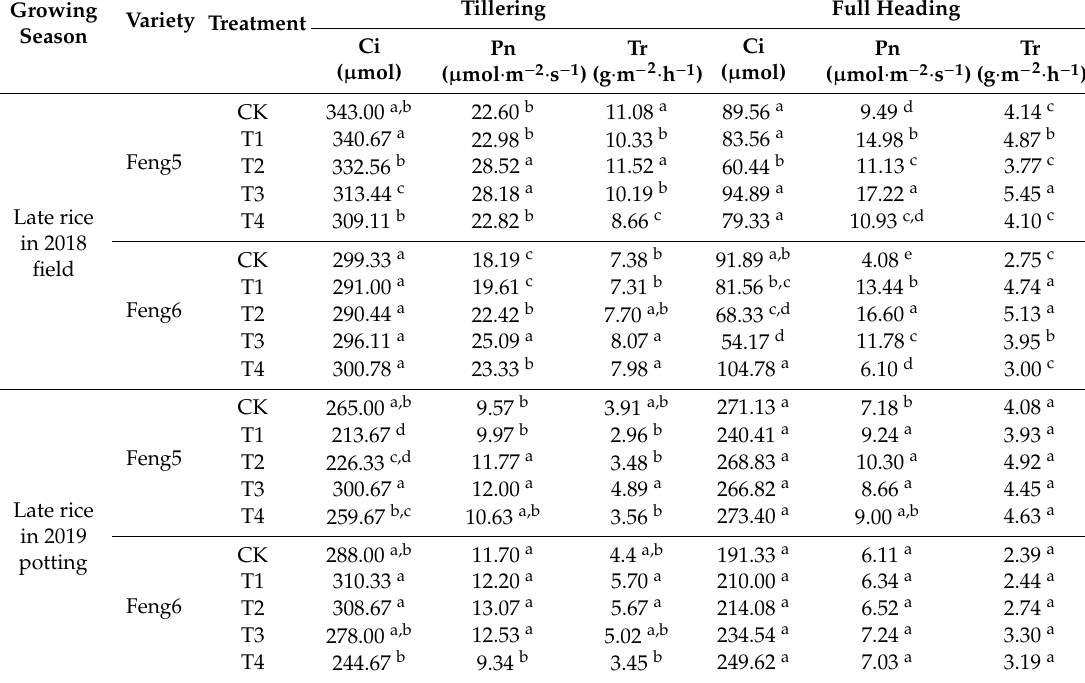
Table 6. Changes of photosynthetic characteristics under nitrogen